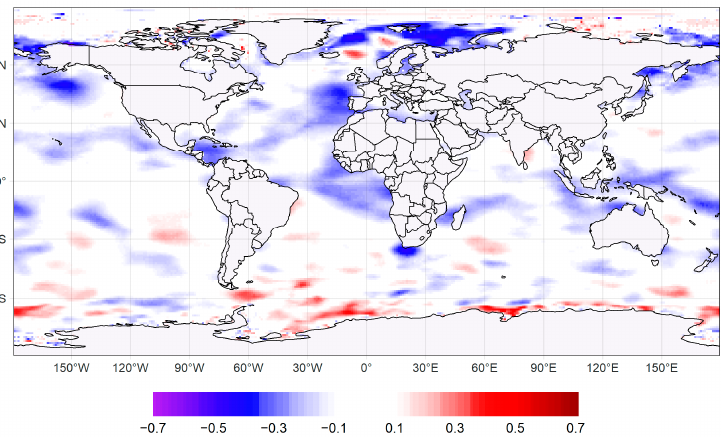
Figure 7. Spatial correlation between maximum annual northern TC extent and annual mean SST.